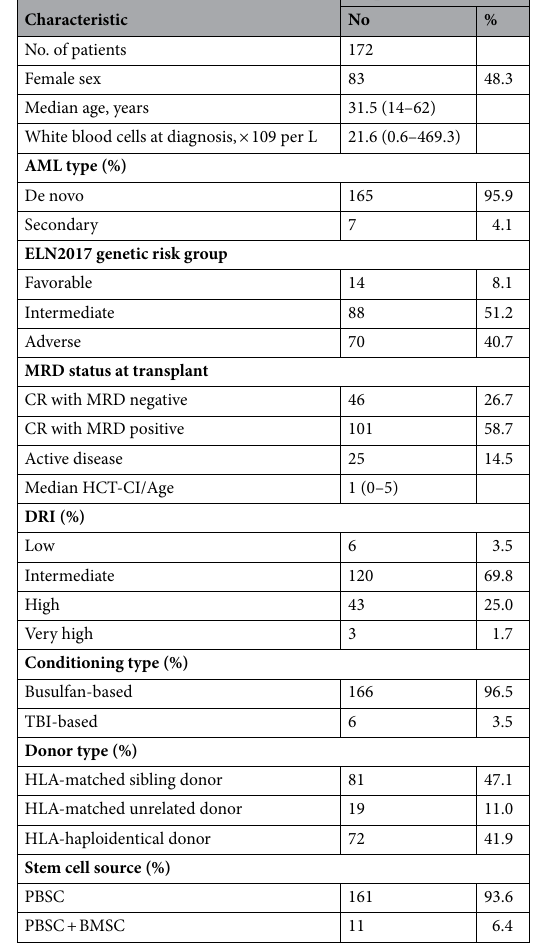
Table 1. Patient characteristics. AML acute myeloid leukemia, CR complete remission, HC CI/Age- comorbidity-age index, DRI disease risk index, BMSC bone marrow stem cell, PBSC peripheral blood stem cell, TBI total body irradiation.